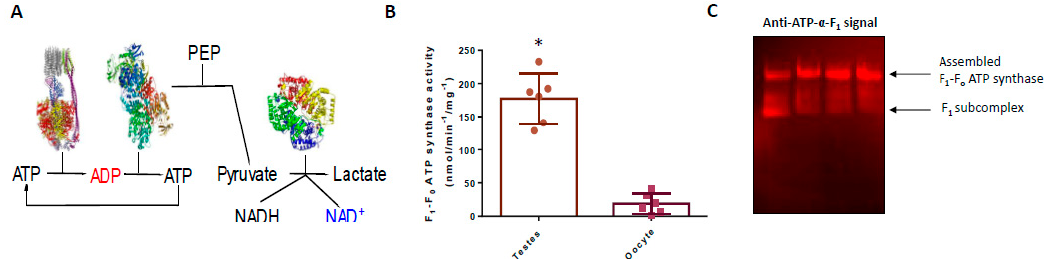
Figure 1. Oligomycin sensitive F 1 -F o ATP synthase activity is significantly greater in testes compared to oocytes. ( A ) The F 1 -F o ATP synthase hydrolysis ATP to ADP. Pyruvate kinase regenerates ATP by